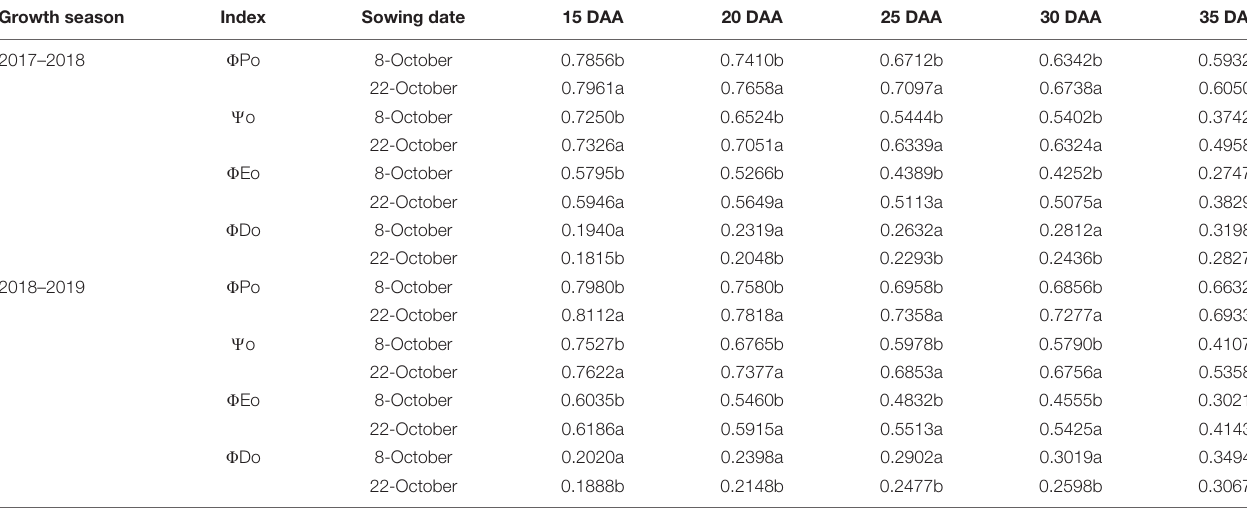
TABLE 2 | Effect of delayed sowing on the energy distribution proportion of wheat flag leaves under heat stress at late grain–filling stage. Growth season